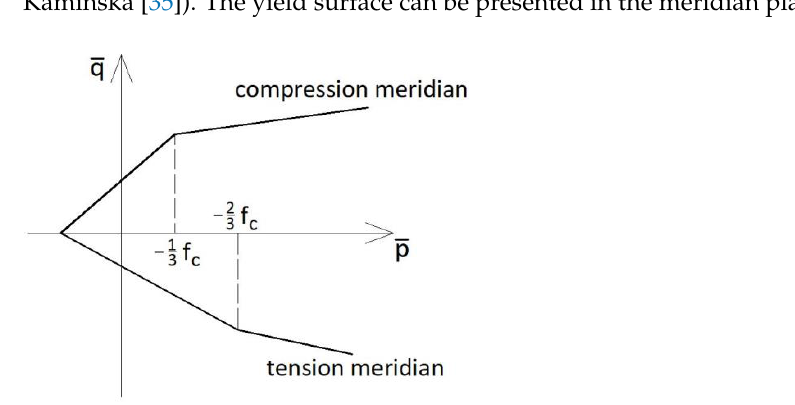
Figure 1. CDP yield surface in the meridian plane.